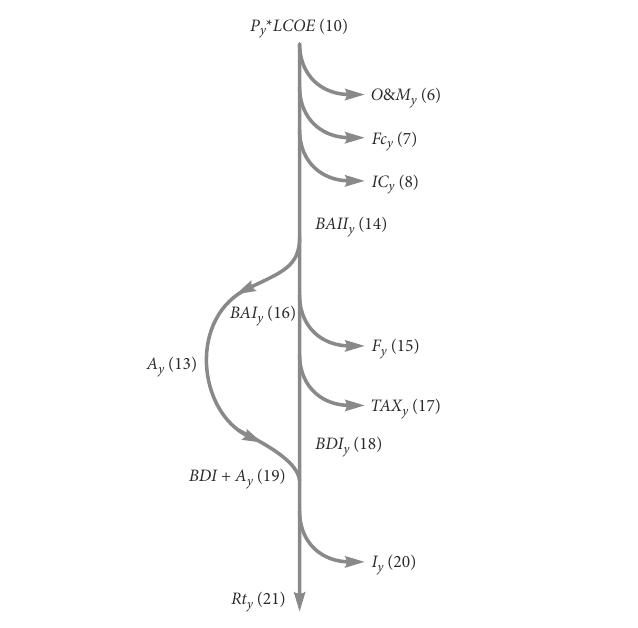
Figure 1. Cash diagram of